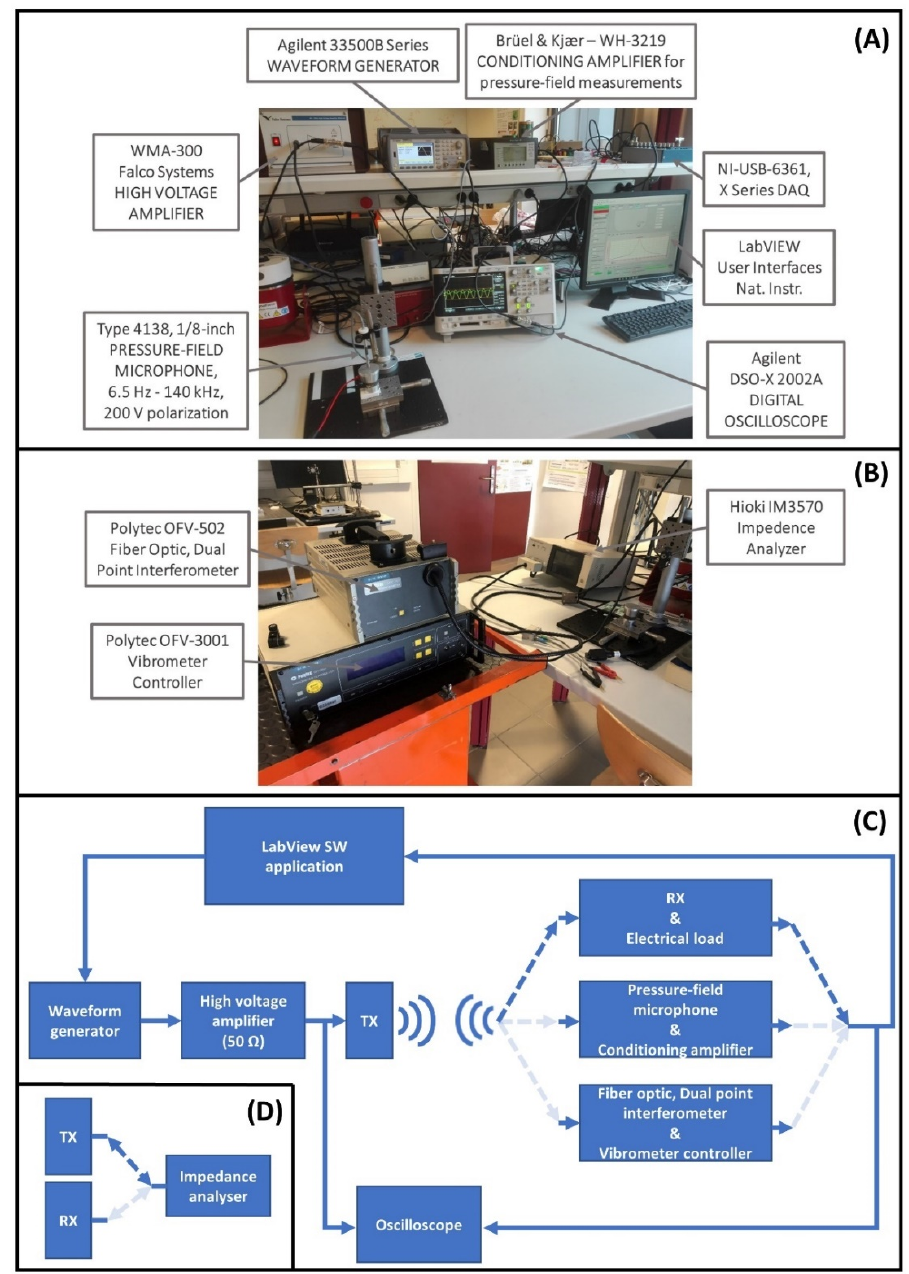
Figure 3. Experimental bench. Waveform generator, high voltage amplifier, conditioning amplifier for pressure-field microphone output, oscilloscope, and National Instrument DAQ and LabVIEW ( A ). Impedance analyzer and Polytec Vibrometer controller for dual point interferometer ( B ). Schematic block diagram of the circuit used for measuring the electrical power output on the load, the acoustic pressure field, and velocity and displacement values for the TX ( C ). Schematic block diagram to measure impedance and phase values of TX and RX ( D ).